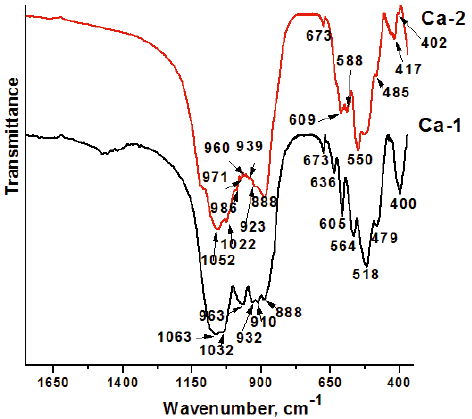
Figure 4. FTIR spectra of synthesized Ca-1 and Ca-2 spectra after immersion in 1.5